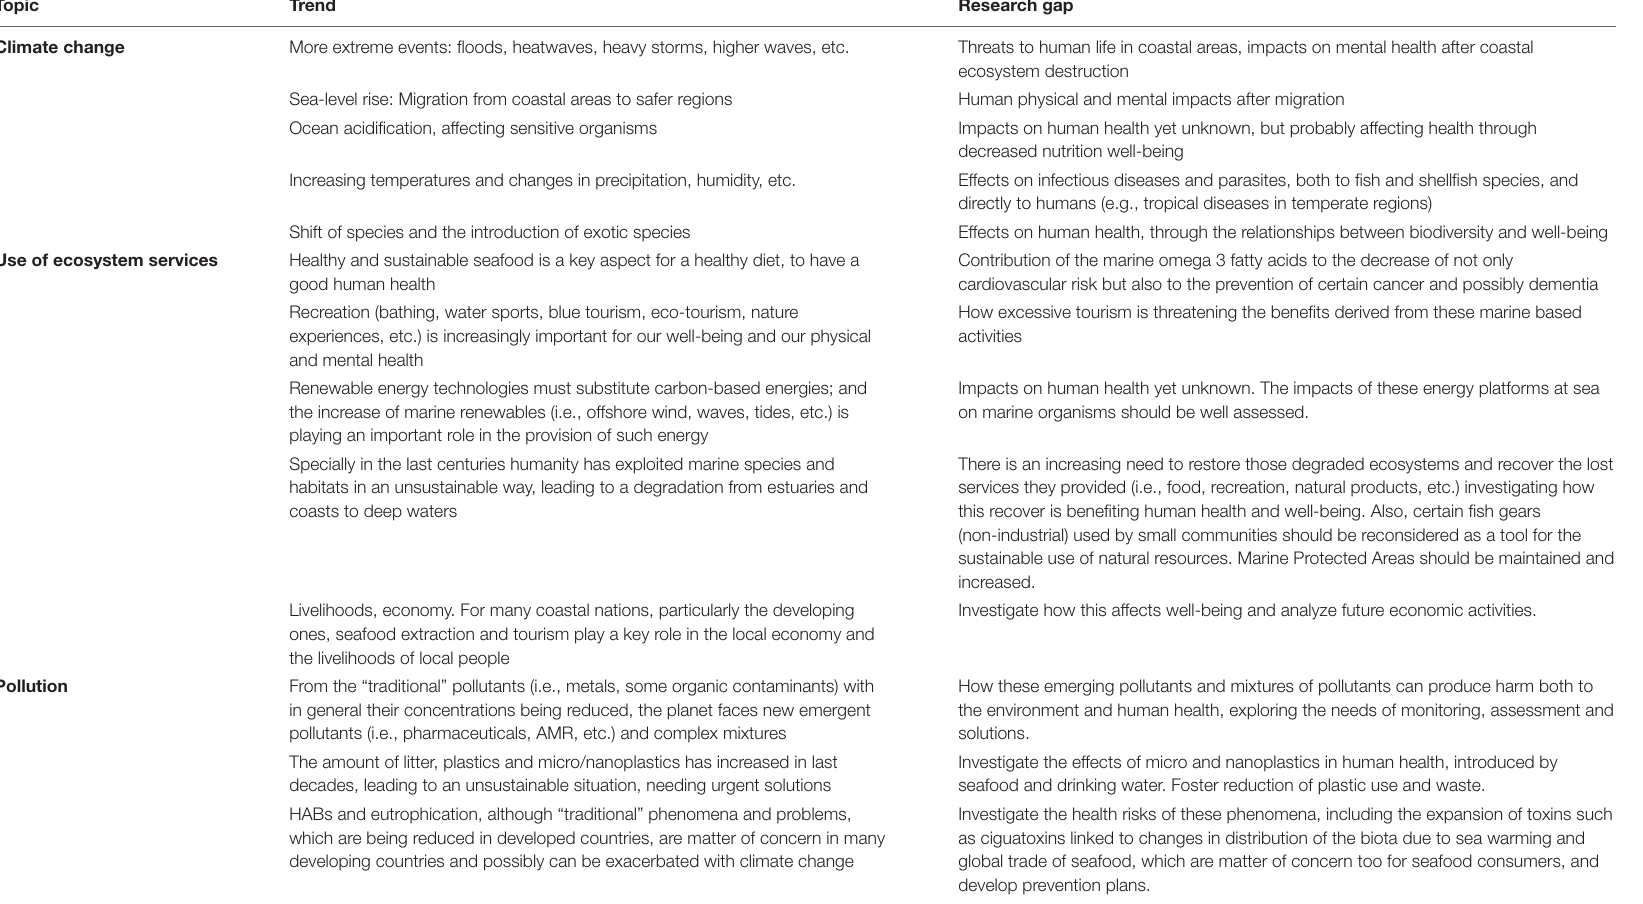
TABLE 2 | List of priorities for research in Oceans Health and Human Health, as identified by the authors of this review, for a series of topics and trends. Topic Trend Research gap Climate